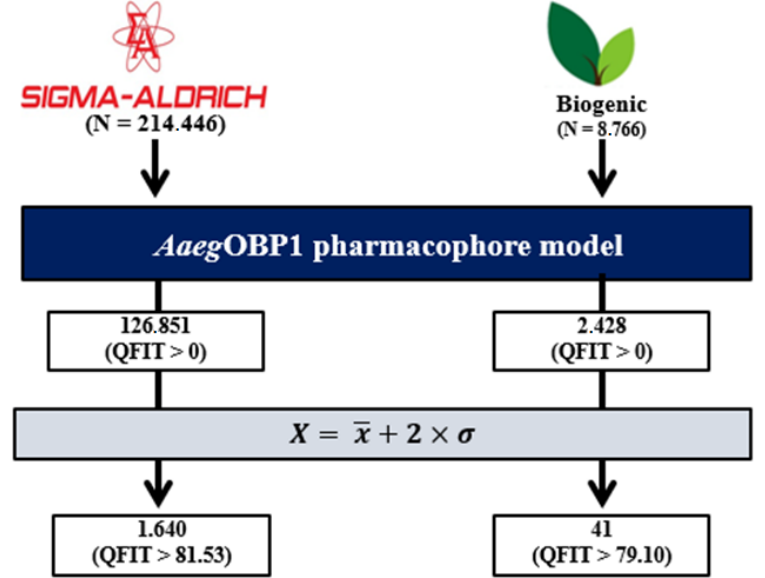
Figure 1. Pharmacophore-based virtual screening steps. Next, of the 8766 compounds from the biogenic database with the pharmacophore model, 2428 compounds had partial stereoelectronic requirements (1.36 < QFIT > 91.80) for target recognition. From this database, 41 compounds (QFIT > 79.10) were finally prioritized [Equation] (Figure